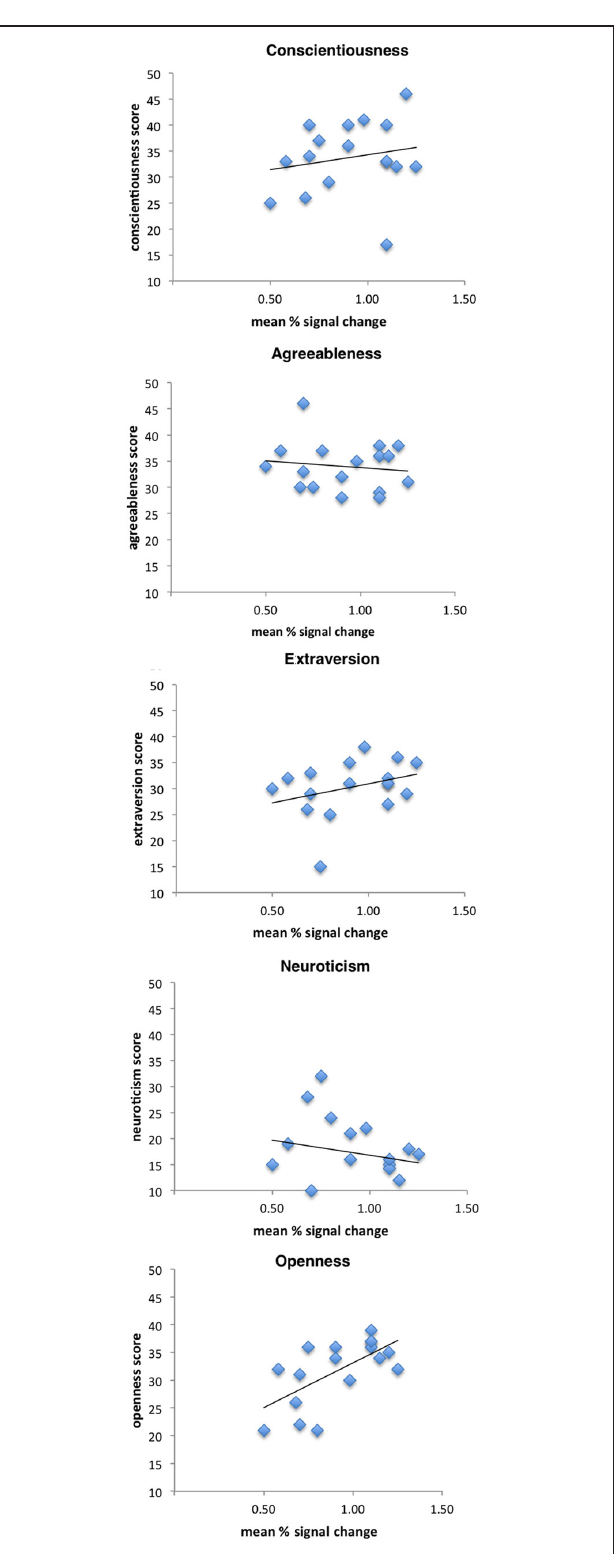
FIGURE 2 | Correlation scatterplots for personality dimensions openness to experience, agreeableness, extraversion, neuroticism, and conscientiousness of the FFM and left SI activation when observing a touched hand (see text for further details).